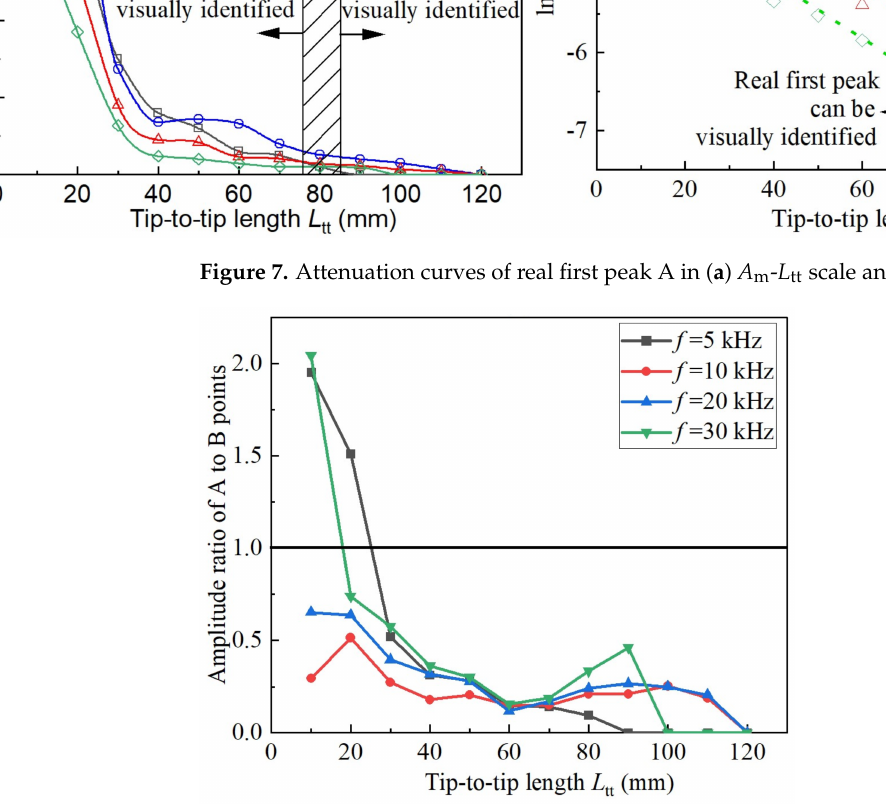
Figure 8. Amplitude ratio of peak point A to peak point